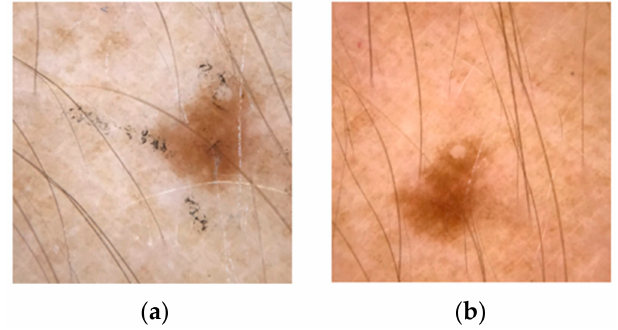
Figure 9. The ( a ) image has some lines with a pen and the ( b ) image is clean.